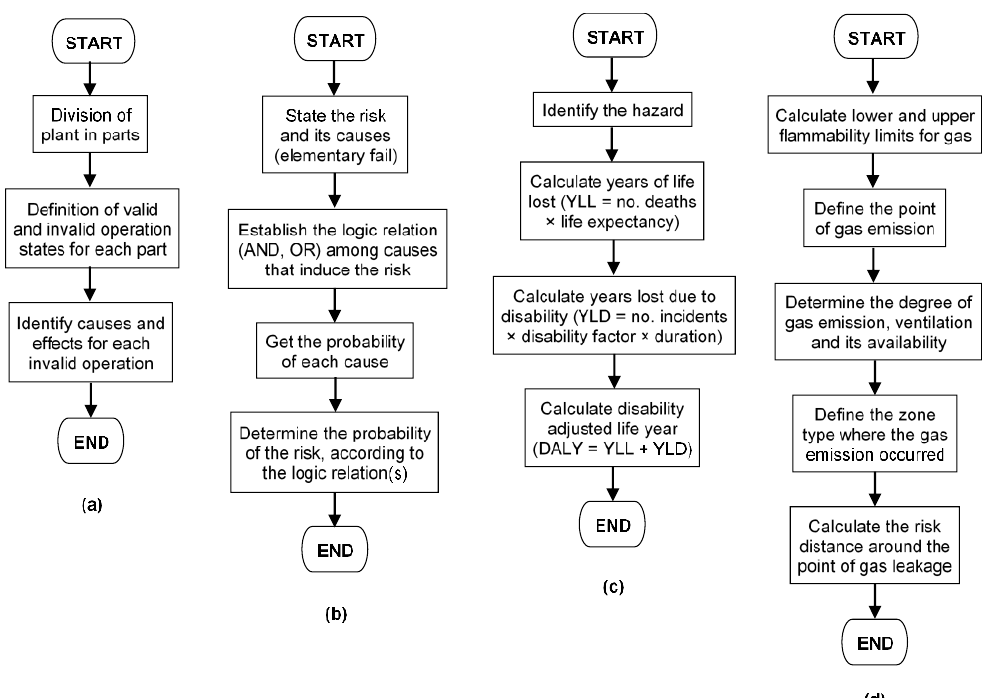
Figure 4. Flowcharts for basic methods identified in the literature and being used in occupational safety analysis of gasification plants: (a) HAZOP; (b) FTA; (c) DALY; (d) defined by Italian standards CEI 31-35 and 35/A and CEI EN 60079-10 (drawn from information at: Abidin et al., 2011; Huuskonen, 2012; Lettner et al., 2008; Molino et al.,